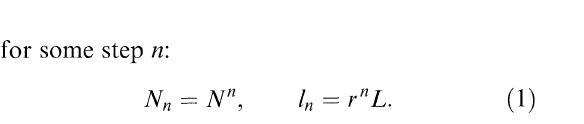
FIGURE 3 A multifractal Sierpinski carpet. Using two re- ducing factors r 1/2 and r= 1/4 products of higher order of these factors occur in course of iteration. Thus a more complex hierarchy is